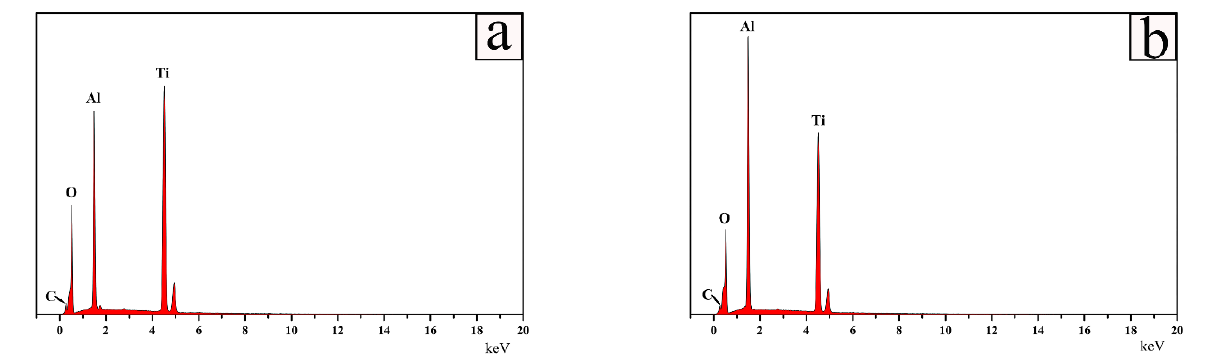
Figure 1. X-ray diffraction (XRD) patterns of Ti 2 AlC samples quenched in air at different tempera- ture: ( a ) 25 °C, ( b ) 480 °C, ( c ) 920 °C, and ( d ) 1150 °C.